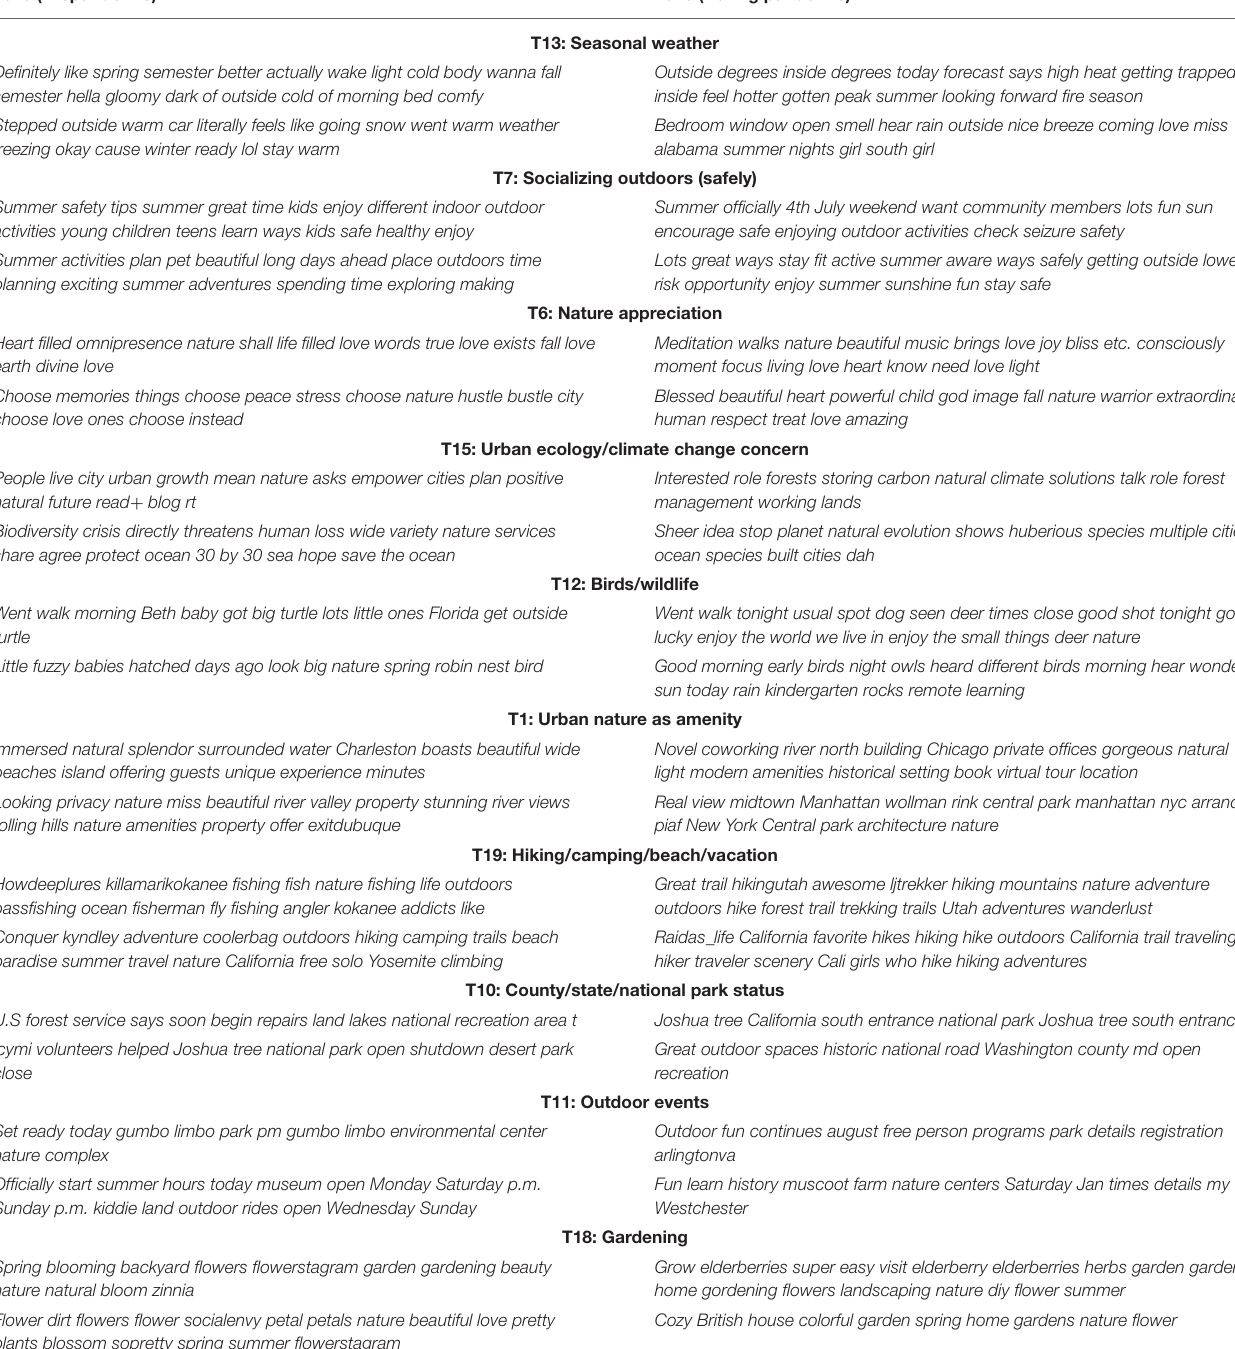
TABLE 2 | Exemplar tweets by retained topic, in order of prevalence.